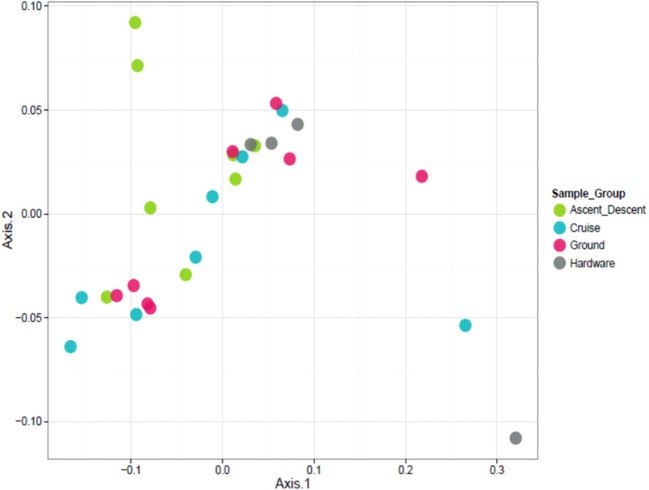
Weighted ordination based on relative abundance showed no clustering by sample group. The first two ordination axes accounted for 77.5% of sample variation.